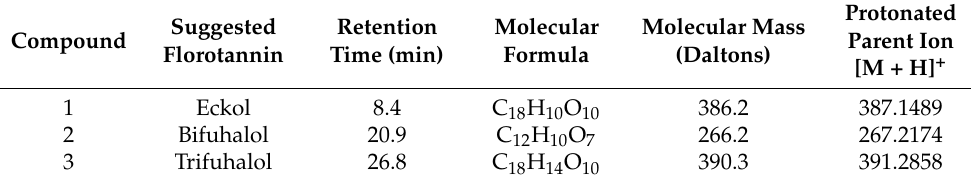
Table 3. Phlorotannins in polyphenol crude extract from S. filipendula.